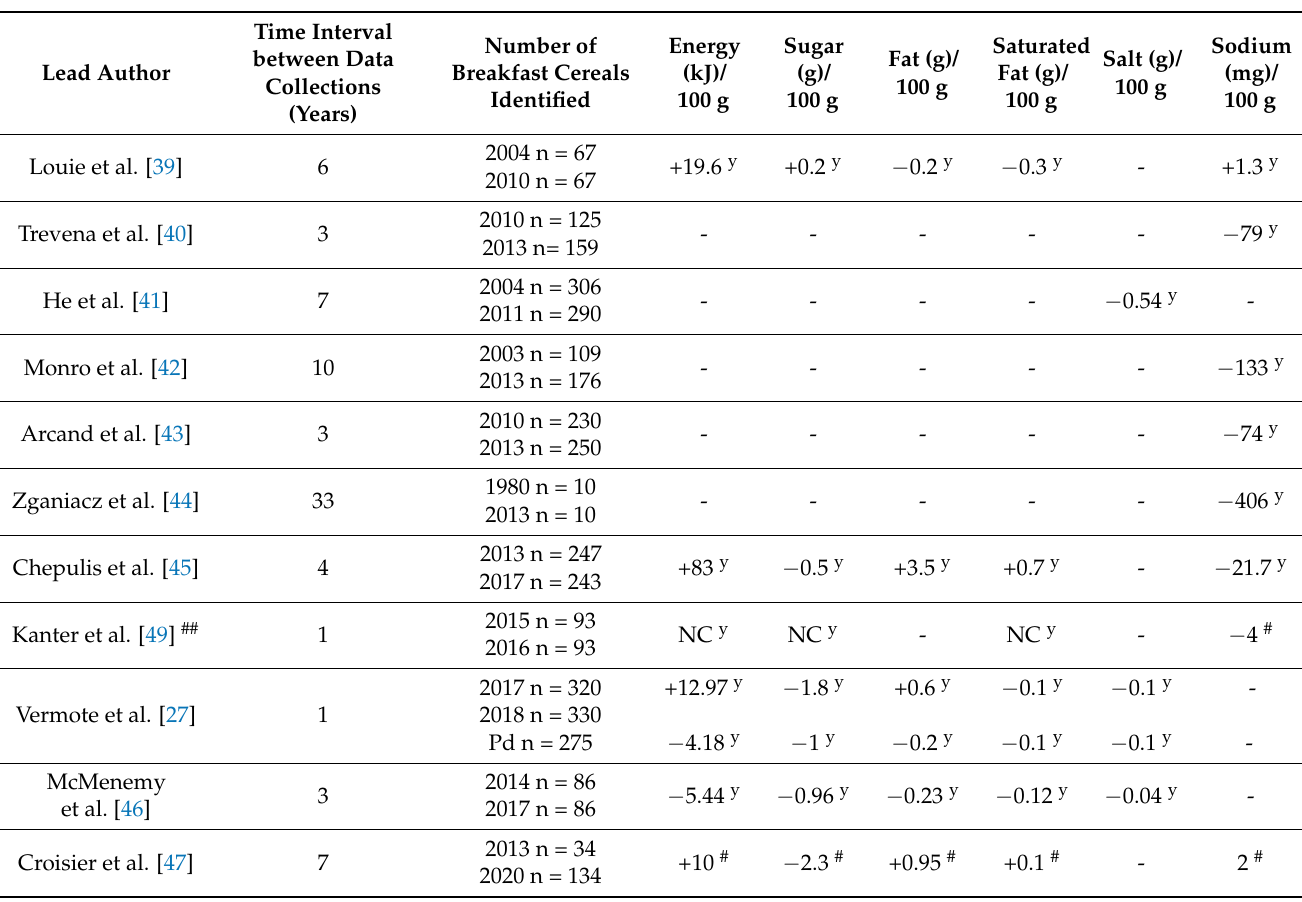
Table 3. Energy (kJ) and nutrient changes in the 11 studies investigating the reformulation of breakfast cereal over